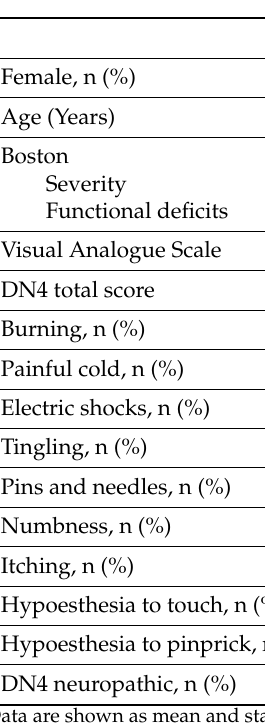
Table 1. Participant